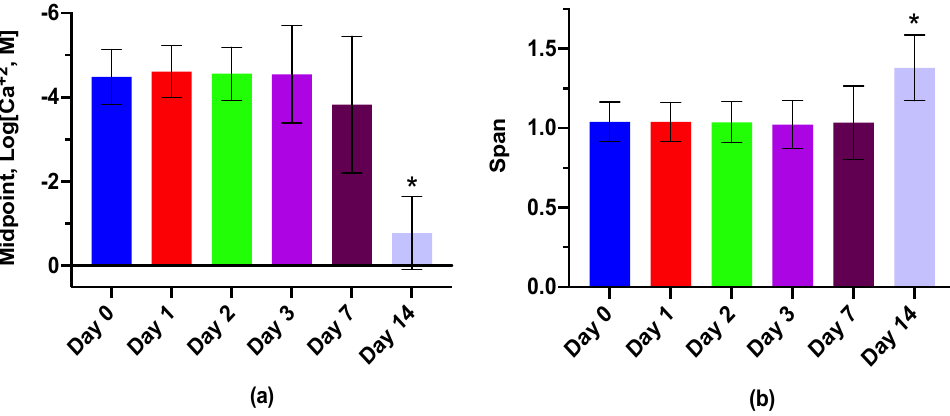
Figure 3. LipiSensors have a functional lifetime of one week. The response character drastically changed between the first and second week ( n = 3). ( a ) Midpoint response as a function of time. By day 14, the sensors are much less sensitive to Ca +2 (* p < 0.0001). ( b ) Sensor span as a function of time. Between day 7 and 14, sensor span increases significantly (* p = 0.0112).